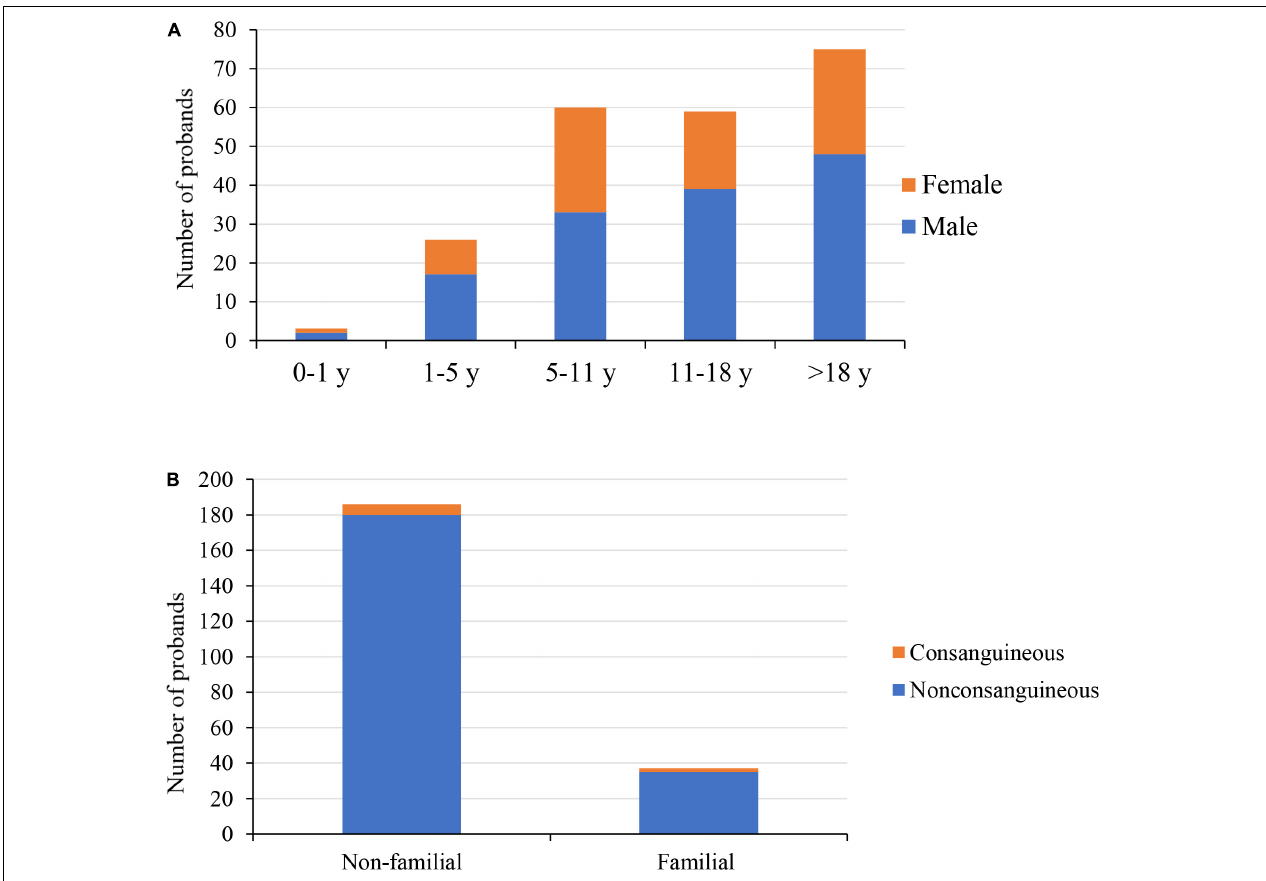
FIGURE 1 | Demographics of the 223 probands. (A) The distribution of gender and age of 223 probands; male accounted for 62%. (B) Family history and parental consanguinity of 223 probands; 4% probands were born to consanguineous parents. y,